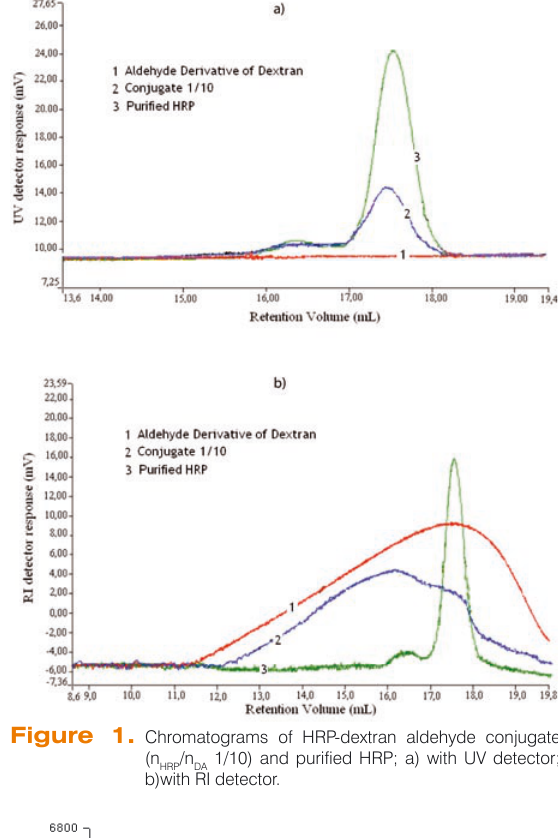
Figure 1. Chromatograms of HRP-dextran aldehyde conjugate (n /n 1/10) and purified HRP; a) with UV detector; HRP DA b)with RI detector.